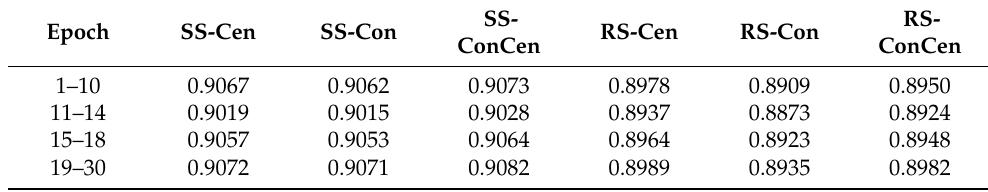
Table 4. Highest recognition rate